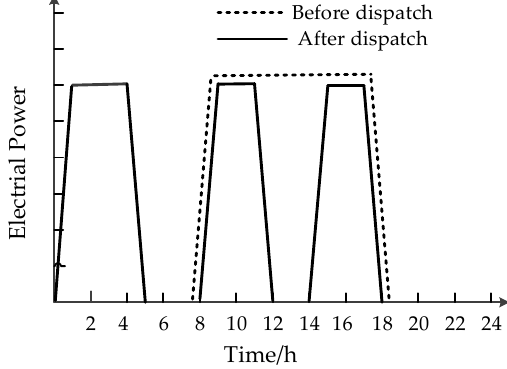
Figure 2. The power curve of the industrial load before and after dispatch.